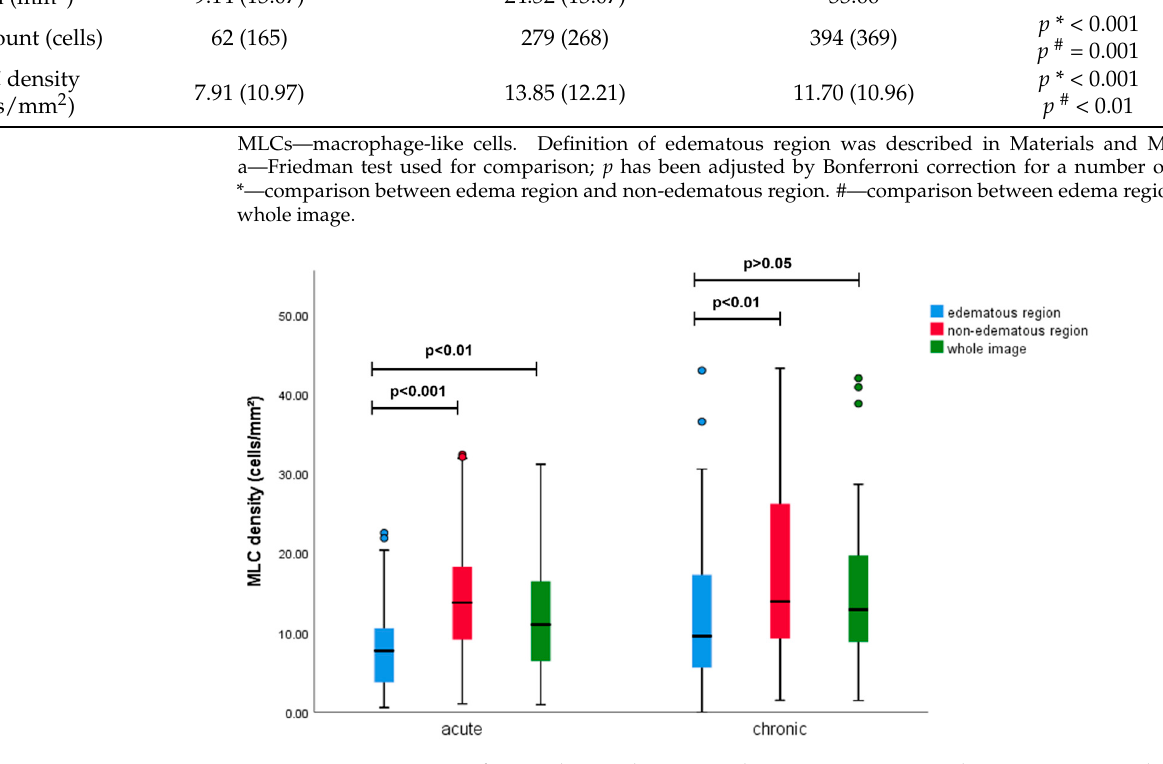
Figure 5. Comparison of MLC density between edematous area, non-edematous area, and whole image in the acute and chronic groups. In the acute group, MLC density reduced significantly in the edematous region compared with the non-edematous region and the whole image. In the chronic group, the MLC density reduced significantly in the edematous region compared with the non-edematous region. There was no significant difference in MLC density between the edematous region and the whole image in the chronic group.